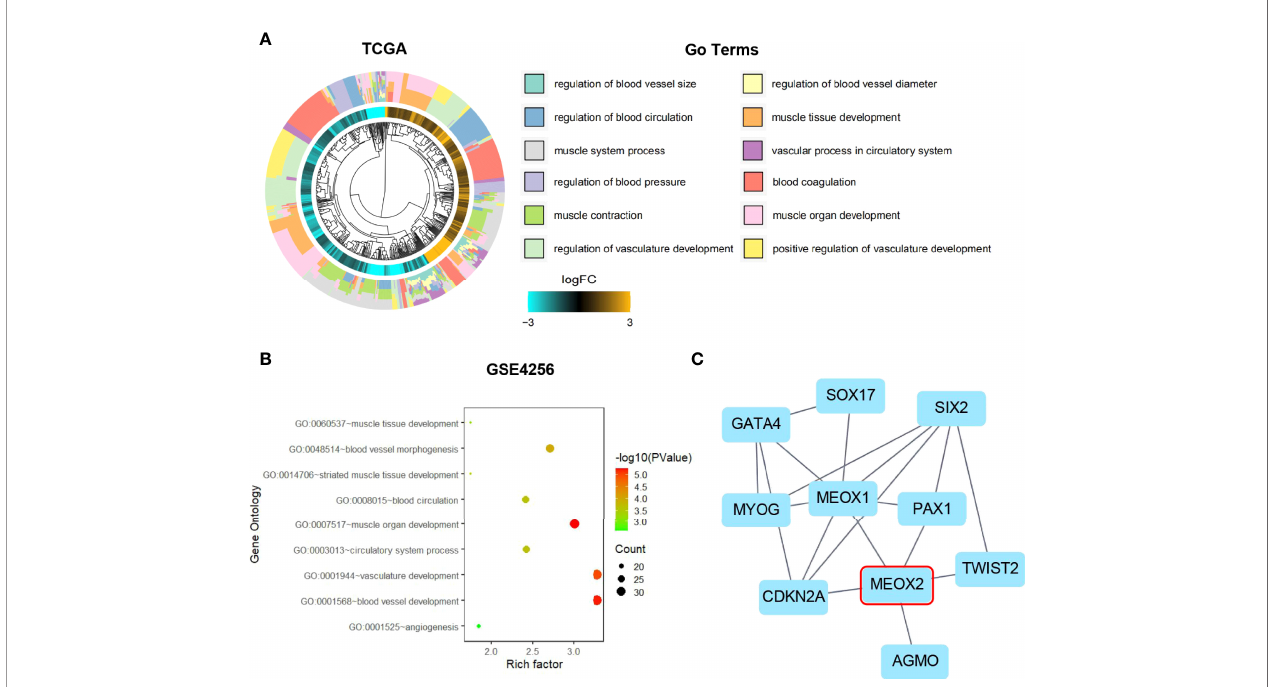
FIGURE 2 | Gene Ontology enrichment and Protein-Protein Interaction analysis. (A) GO analysis of the TCGA dataset for the MEOX2 gene. (B) GO analysis of the GEO dataset GSE42568. (C) The signi fi cant module from the PPI